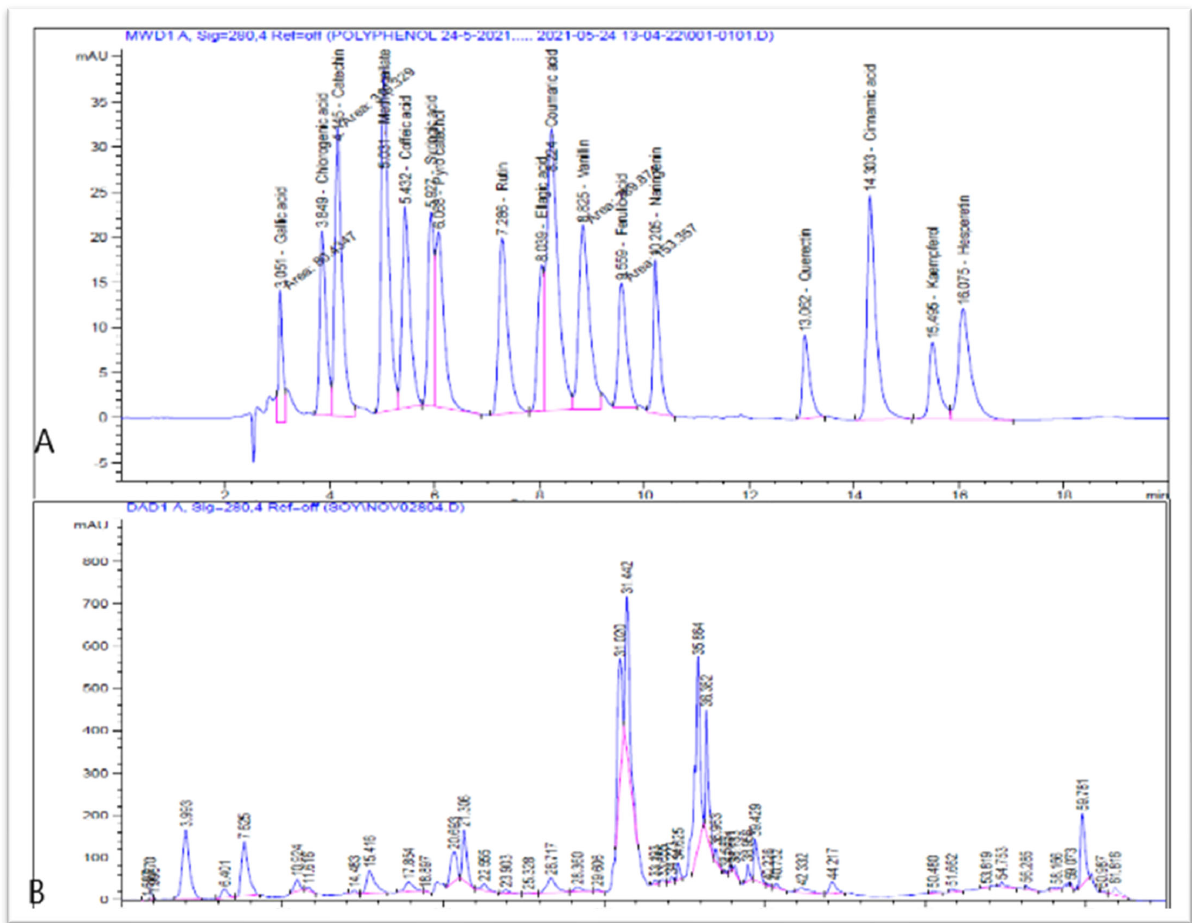
Figure 1. The chromatograms of ( A ) standard phenolic compounds and ( B ) CV crude extract. Table 2. The effect of different treatments on body weight gain and liver or brain ‐ to ‐ body mass percentage.